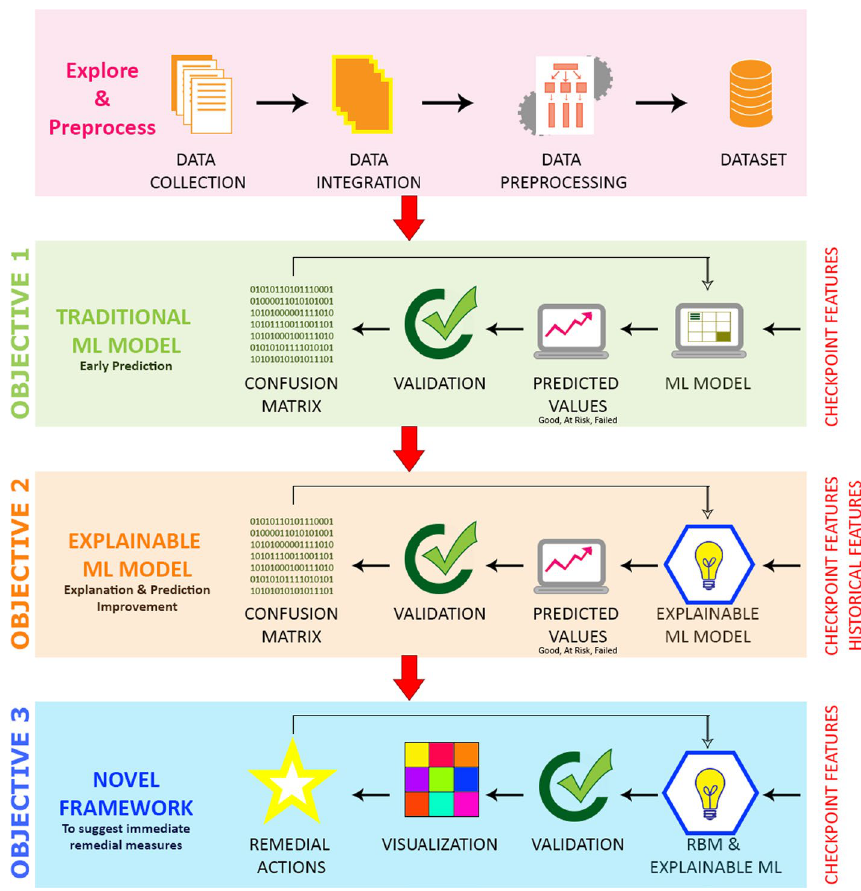
Fig. 1 Overview of methodology of this